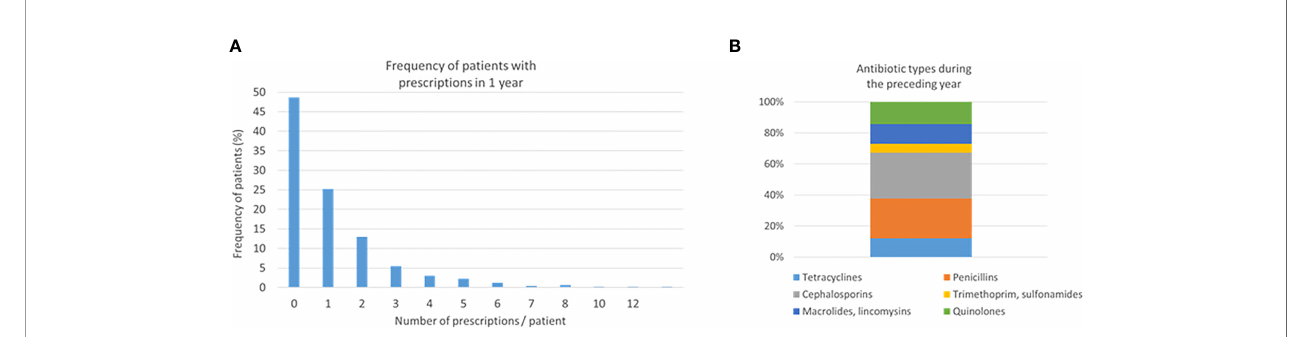
FIGURE 1 | Number of prescriptions and antibiotic types. Two hundred sixty-one (51.7%) patients were prescribed with antibiotics during the preceding 1 year. Frequencies of the number of prescriptions (A) and antibiotic types (B)